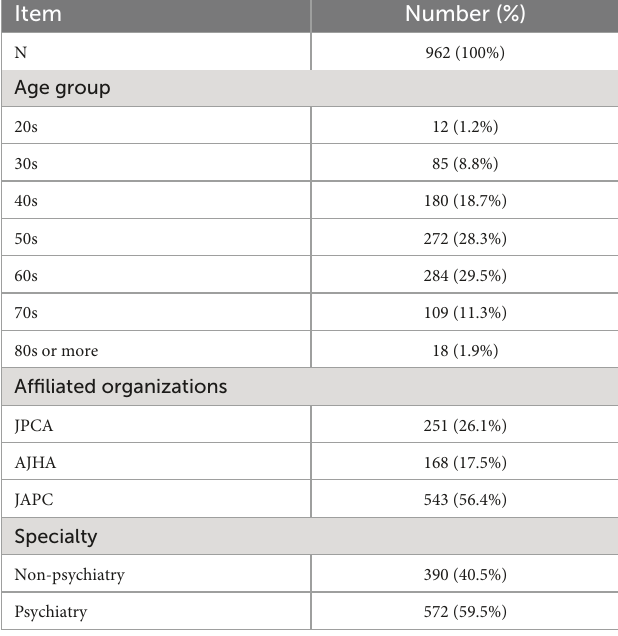
TABLE 1 Characteristics of the